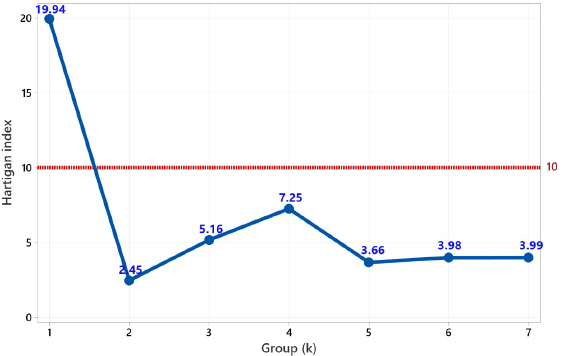
Figure 1. Hartigan Index plot to determine the number of groups from Indonesian Insurance data.